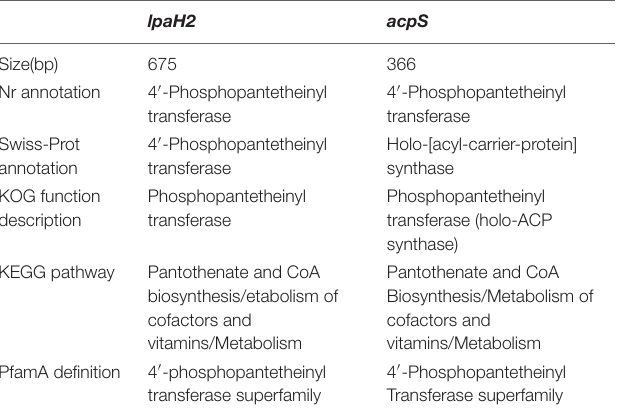
TABLE 4 | Comparison of gene function bioinformatics analysis between lpaH2 and